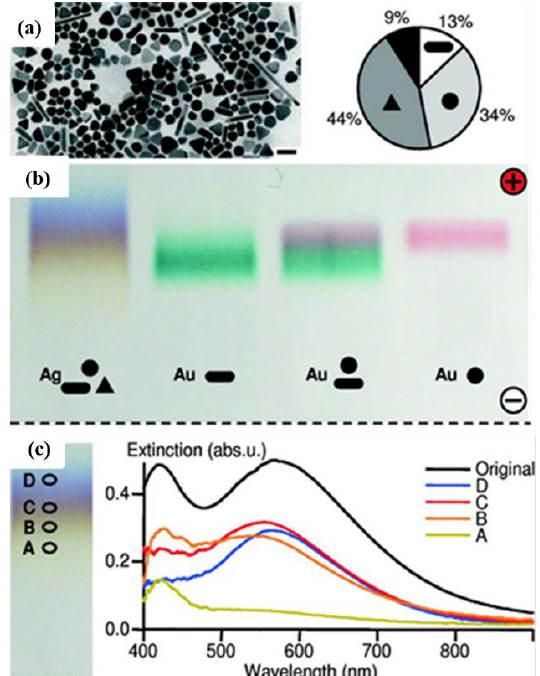
Figure 6. ( a ) TEM image of AgNPs sample and graphical distribution of the different shapes of the nanoparticles; ( b ) photograph of an agarose gel run for separation of nanoparticles (0.2% agarose, 30 min run, 150 V, 0.5× TBE buffer); ( c ) separated fractions of silver nanoparticles in agarose gel and their extinction spectra. Reprinted and adapted with permission from [46] , copyright (2007) American Chemical Society.